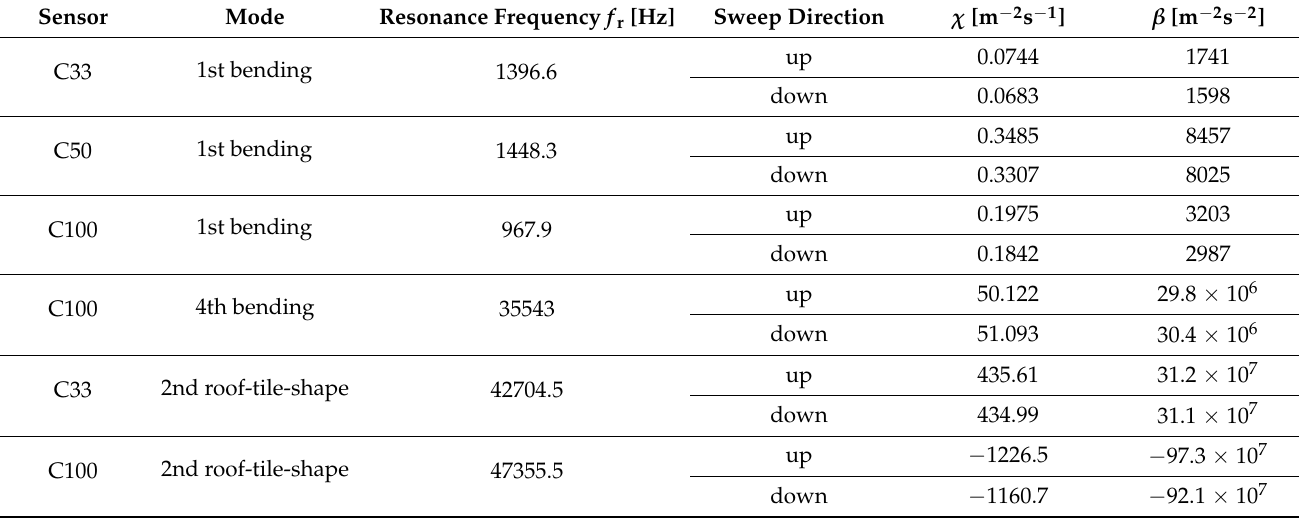
Table 2. Listing of determined key parameters for the presented sensors and mode shapes of Figure 7.